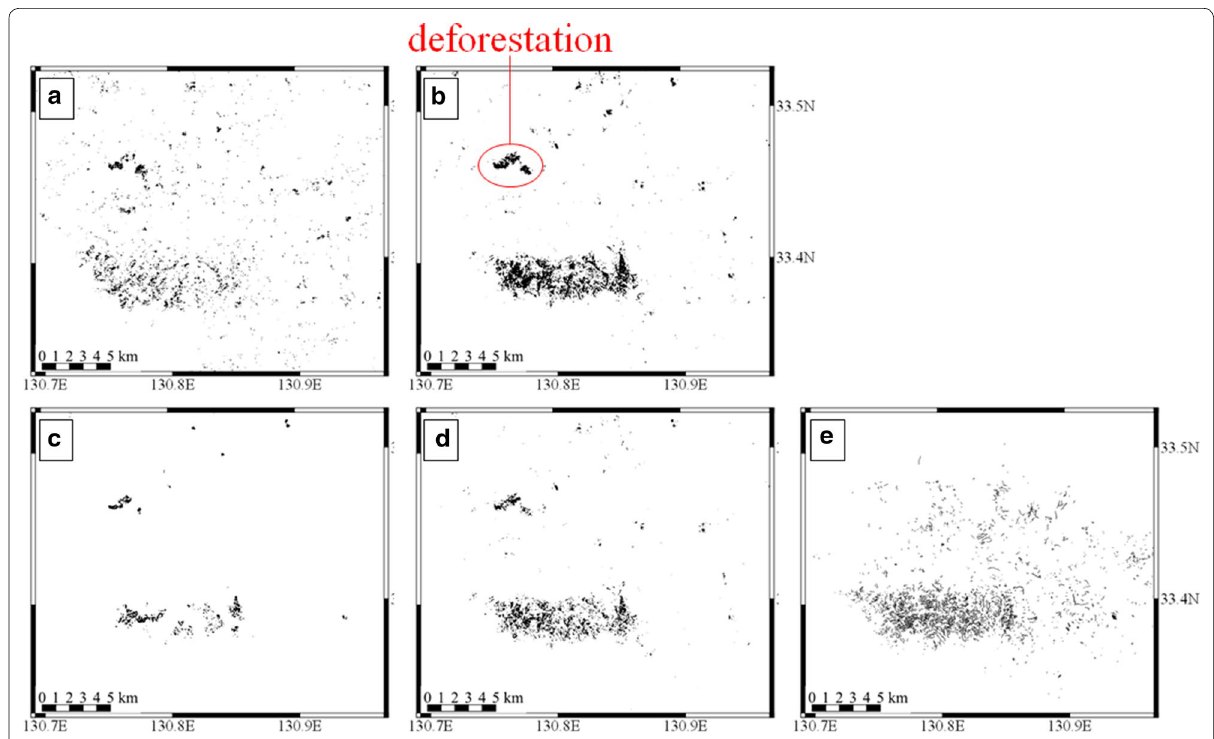
Fig. 4 Landslides caused by the July 2017 Heavy Rain in Northern Kyushu (site F) as detected by the empirical approach ( a ) and the supervised classification using PolSAR, InSAR and DEM features ( b–d ), compared with the reference data by GSI (2017) ( e ). b Used the training data from the same site, c used the training data from the other site, d used only single-polarization (HH)